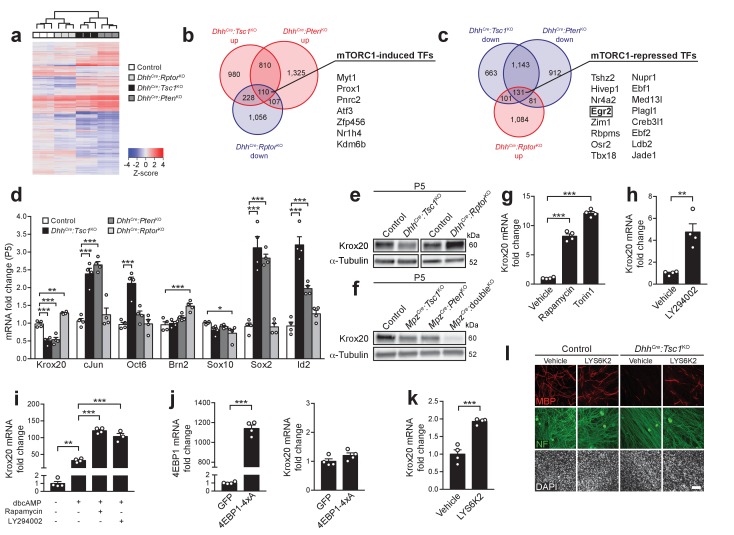
mTORC1 negatively regulates Krox20 expression via S6K.(a) Cluster analysis and heatmap of transcriptome profiles from P5 control, DhhCre:RptorKO, DhhCre:Tsc1KO, and DhhCre:PtenKO sciatic nerves (n = 3 mice/genotype). (b,c) Venn diagrams of differentially expressed genes relative to controls (fold change >1.2, FDR < 0.05). (d) qRT-PCR analysis from P5 sciatic nerves. Transcript levels relative to control, after normalization to β-actin. Bar height: Mean; error bars: s.e.m. (n = 4 mice/genotype, one-way ANOVA with Dunnett’s multiple comparisons test, F(3,12)Krox20 = 61.75, F(3,12)cJun = 34.14, F(3,12)Oct6 = 19.85, F(3,12)Brn2 = 13.11, F(3,12)Sox10 = 3.747, F(3,12)Sox2 = 44.76, F(3,12)Id2 = 49.23, pKrox20 <0.0001, pcJun <0.0001, pOct6 <0.0001, pBrn2 <0.0001, pSox10 = 0.0414, pSox2 <0.0001, pId2 <0.0001; Krox20, pcontrol vs TSC1KO = 0.0001, pcontrol vs PTENKO = 0.0001, pcontrol vs RaptorKO = 0.0017; cJun, pcontrol vs TSC1KO = 0.0001, pcontrol vs PTENKO = 0.0001; Oct6, pcontrol vs TSC1KO = 0.0001; Brn2, pcontrol vs RaptorKO = 0.0003; Sox10, pcontrol vs RaptorKO = 0.0212; Sox2, pcontrol vs TSC1KO = 0.0001, pcontrol vs PTENKO = 0.0001; Id2, pcontrol vs TSC1KO = 0.0001, pcontrol vs PTENKO = 0.0006). (e,f) Western blot analysis, P5 sciatic nerve lysates (n = 3 mice/genotype). Quantification: Figure 3—figure supplement 2a,b. (g) qRT-PCR from primary rat SCs in growth medium treated with vehicle (DMSO), rapamycin (20 nM), or torin-1 (20 nM) for 24 hr. Transcript levels relative to vehicle, after normalization to GAPDH. Bar height: Mean; error bars: s.e.m. (n = 4 biological replicates/condition, one-way ANOVA with Dunnett’s multiple comparisons test, F(2,9) = 378, p<0.0001; pvehicle vs rapamycin = 0.0001, pvehicle vs torin1 = 0.0001). Three independent experiments performed, one exemplary experiment shown. (h) qRT-PCR from primary rat SCs in growth medium treated with vehicle (DMSO) or LY294002 (20 μM) for 24 hr. Transcript levels relative to vehicle, after normalization to GAPDH. Bar height: Mean; error bars: s.e.m. (n = 4 biological replicates/condition, two-tailed unpaired Student’s t-test, t(6) = 4.969, p=0.0025). Three independent experiments performed, one exemplary experiment shown. (i) qRT-PCR from primary rat SCs in defined medium with or without dbcAMP and treated with vehicle (DMSO), rapamycin (20 nM), or LY294002 (20 μM) for 24 hr. Transcript levels relative to defined medium-treated cells, after normalization to GAPDH. Bar height: Mean; error bars: s.e.m. (n = 3 biological replicates for LY294002 treated cells, n = 4 biological replicates for the other conditions, one-way ANOVA with Tukey’s multiple comparisons test, F(3,11) = 179.5, p<0.0001; pdefined medium vs dbcAMP vehicle = 0.0012, pdbcAMP vehicle vs dbcAMP rapamycin <0.0001, pdbcAMP vehicle vs dbcAMP LY294002 <0.0001). Three independent experiments performed, one exemplary experiment shown. (j) qRT-PCR from primary rat SCs in growth medium 48 hr after transfection with plasmids expressing GFP or constitutively active 4EBP1 (4EBP1-4xA). Transcript levels relative to GFP-transfected cells, after normalization to GAPDH. Bar height: Mean; error bars: s.e.m. (n = 4 biological replicates/condition, two-tailed unpaired Student’s t-test; 4EBP1, t(6) = 33.37, p<0.0001; Krox20, t(6) = 1.641, p=0.1519). Three independent experiments performed, one representative experiment shown. (k) qRT-PCR from primary rat SCs in growth medium treated with vehicle (DMSO) or LYS6K2 (3 μM) for 24 hr. Transcript levels relative to vehicle, after normalization to GAPDH. Bar height: Mean; error bars: s.e.m. (n = 4 biological replicates/condition, two-tailed unpaired Student’s t-test, t(6) = 7.171, p=0.0004). Three independent experiments performed, one representative experiment shown. (l) Immunostaining of DRG-explant cultures from control or DhhCre:Tsc1KO embryos. Vehicle (DMSO) or LYS6K2 (3 μM) were added upon induction of myelination. Quantification: Figure 3—figure supplement 1e. Three independent experiments performed, one representative experiment shown. MBP: myelin basic protein. NF: neurofilament. Scale bar: 100 μm, refers to whole panel. *p<0.05, **p<0.01, ***p<0.001.10.7554/eLife.29241.012Figure 3—source data 1.Transcriptomes of TSC1-, PTEN-, and Raptor-mutant nerves at P5 compared to controls.